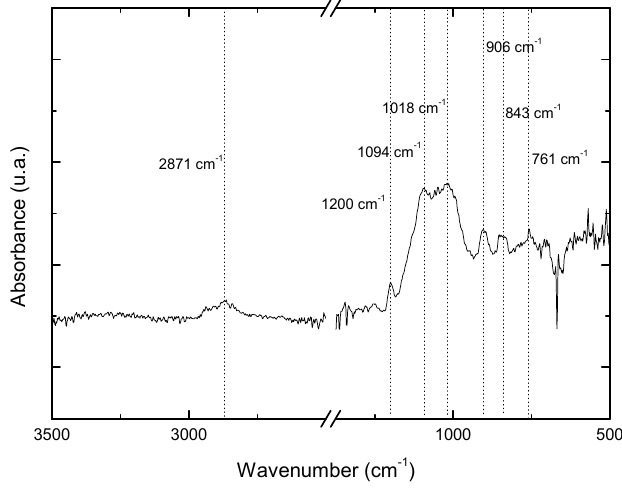
Figure 12. FTIR of the film produced on the aluminum specimen silanized with 3% GPTMS after drying.